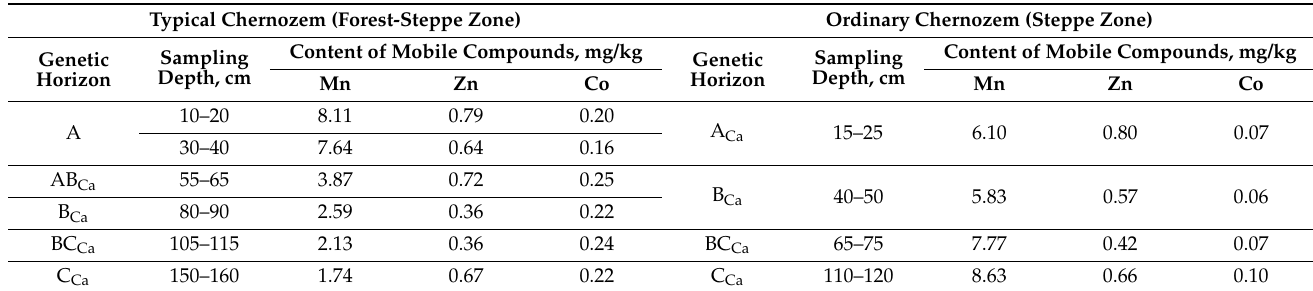
Table 5. The average contents of mobile trace elements in soil profiles of reserved typical and ordinary chernozems, mg/kg.